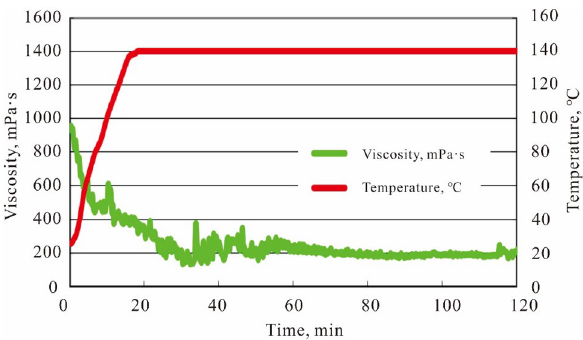
2 weighted fracturing fluid